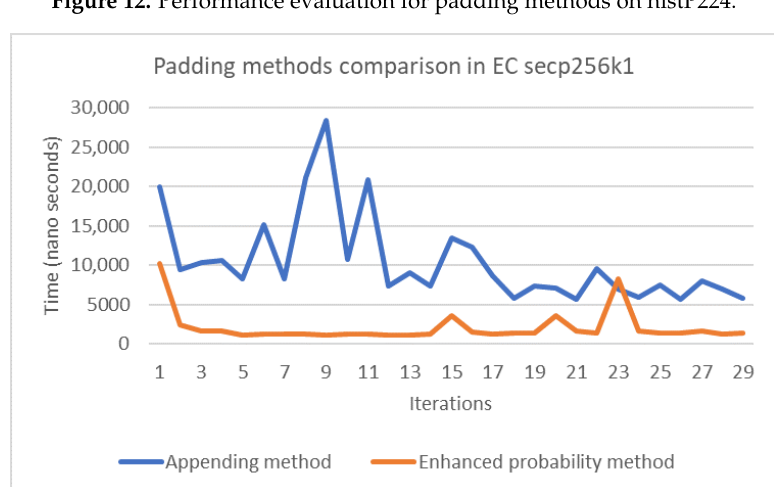
Figure 13. Performance evaluation for padding methods on